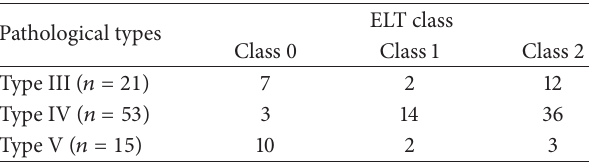
Table 3: ELT formation patterns in renal tissues comprising differ- ent LN pathological